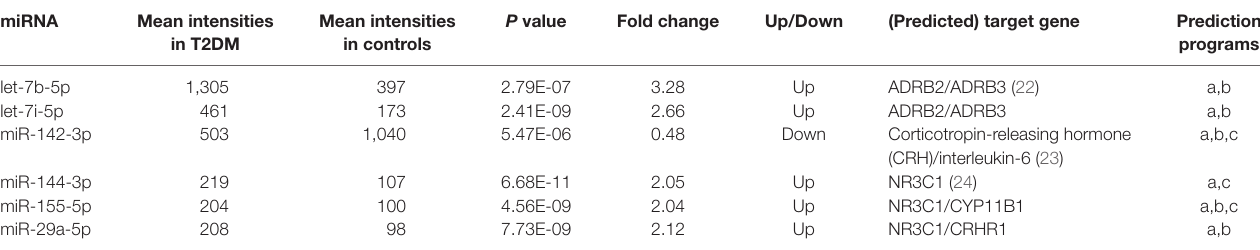
TaBle 2 | Differential microRNAs (miRNA) expression in type 2 diabetes mellitus (T2DM) vs. control group. mirna Mean intensities Mean intensities P value Fold change Up/Down (Predicted) target in T2DM in controls